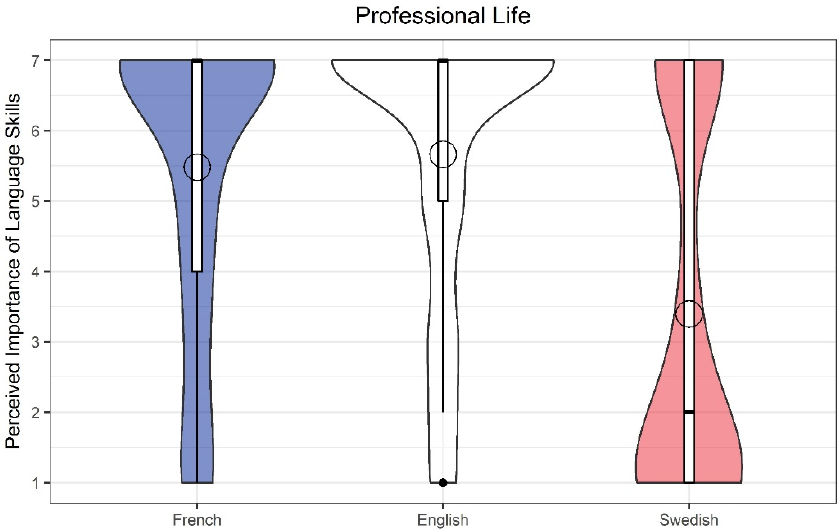
Figure 1. Violin plots overlaid with box plots and means (circles) illustrating the distribution of the perceived importance of skills in each language in professional life. The width of the violin plots represents the proportion of the ratings at each level.